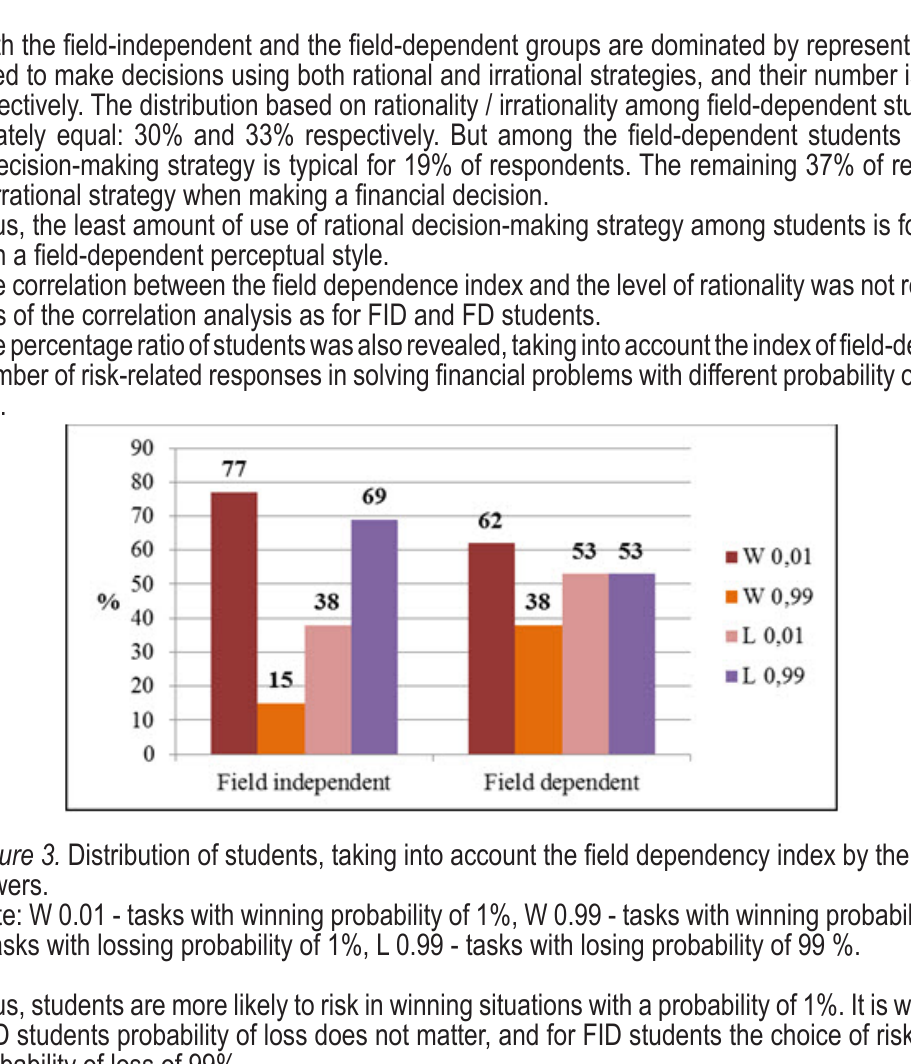
Figure 2. Distribution of field independent / field dependent students taking into account the rationality of choice